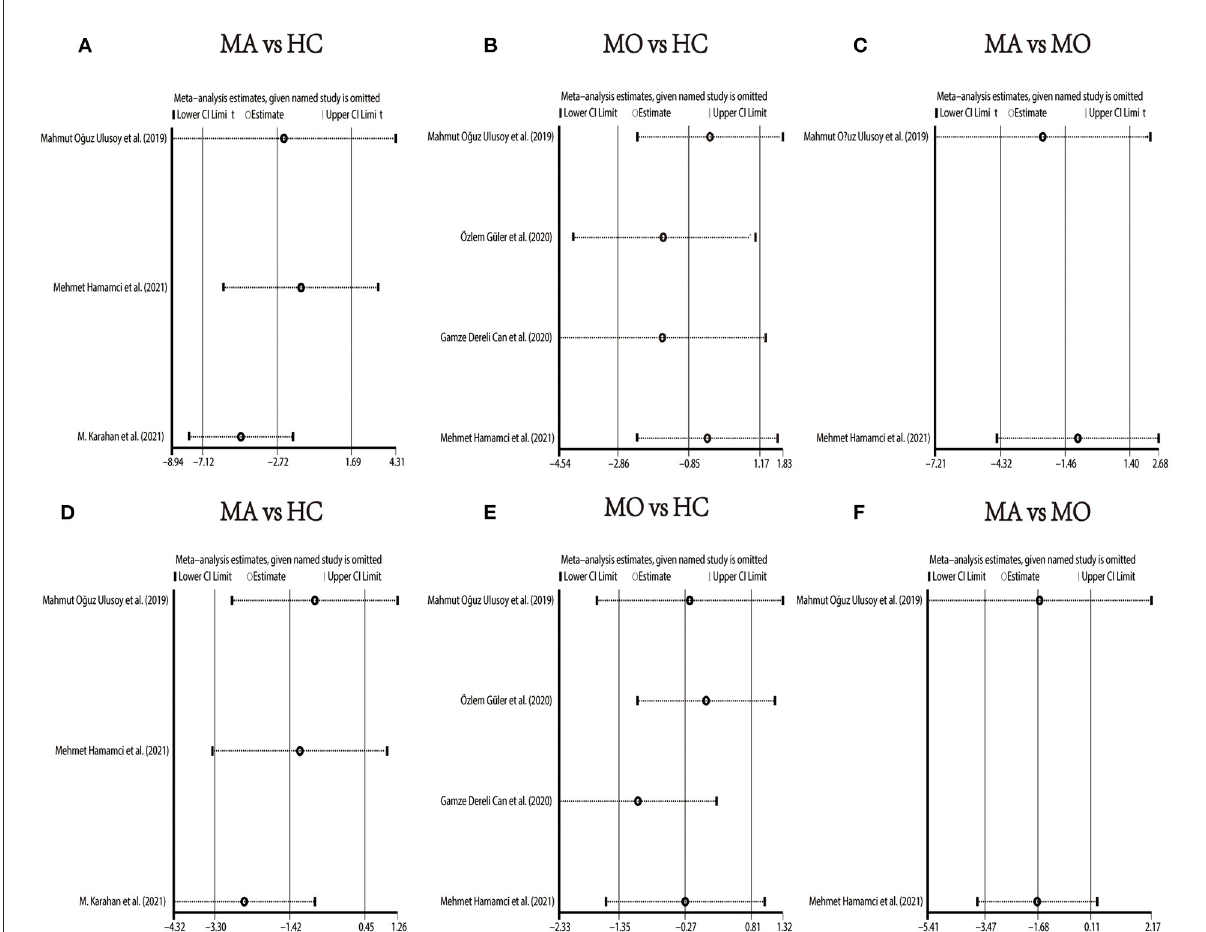
FIGURE6 Sensitivity analysis data for studies included reported VD in the SCP. (A) Foveal VD comparison of MA and HC; (B) foveal VD comparison of MO and HC; (C) foveal VD comparison of MA and MO; (D) parafoveal VD comparison of MA and HC; (E) parafoveal VD comparison of MO and HC; (F) parafoveal VD comparison of MA and